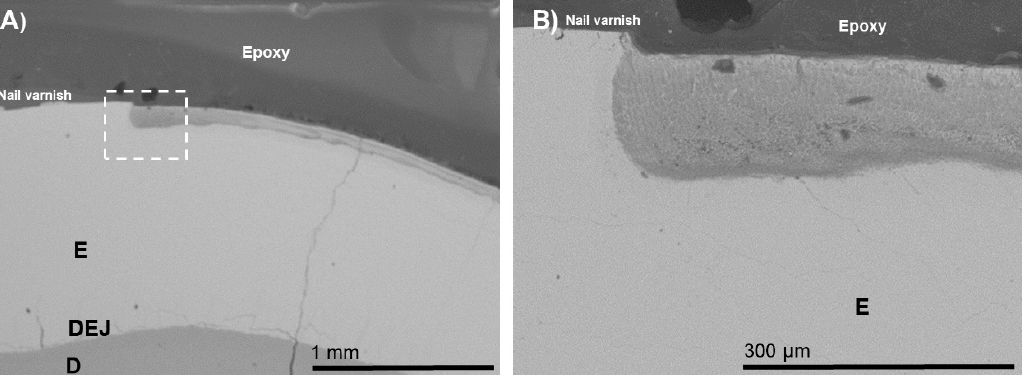
Figure 2. SEM images of the specimens in the bacteria-induced enamel demineralization followed by remineralization in PILP solution containing fluoride and no process-directing agent (BIED-REM F group). ( B ) High-magnification SEM image of ( A ) showing the area under the dotted outline rectangle revealed thick electron-dense zone at the outer zone of the enamel lesion (area between the triangles). E: enamel; D: dentin; DEJ: dentin–enamel junction.